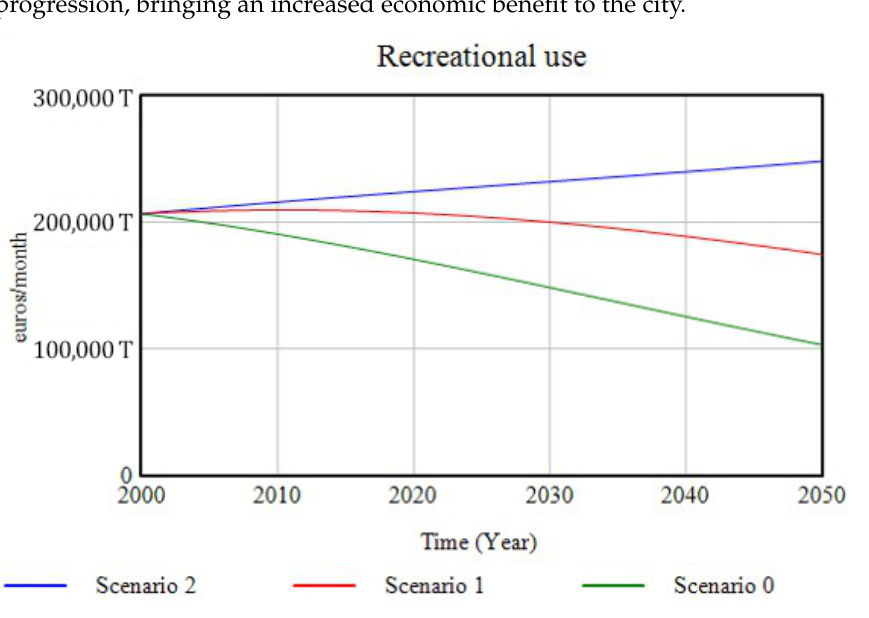
Figure 19. The progression of the ecosystem service “recreational use” for the three simulated scenarios over the period 2000-2050.